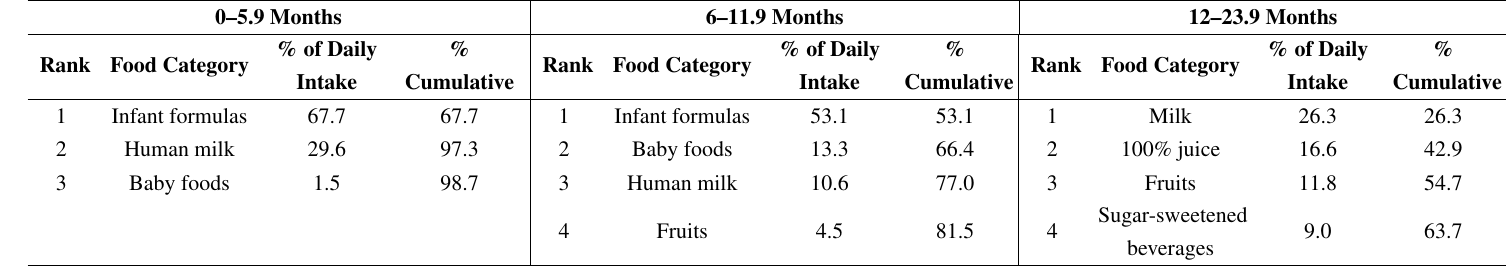
Table 7. Food sources of total sugars among US infants and toddlers aged 0–23.9 months by age group: NHANES 2005–2012 ( n = 2740) a